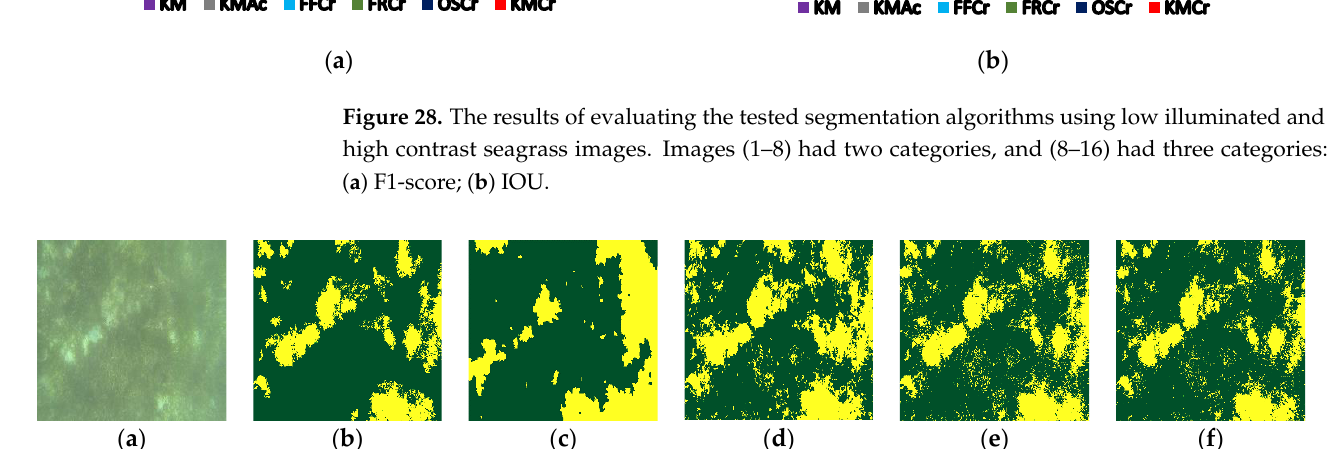
Figure 29. Validation tests of the proposed segmentation algorithms using highly illuminated and low contrast seagrass image (1) from Figure 27 as example of two categories: ( a ) original image; ( b ) ground truth image; ( c ) FF result; ( d ) FR result; ( e ) OS result; ( f ) KM result. Dark green: seagrass, and yellow: sediments.